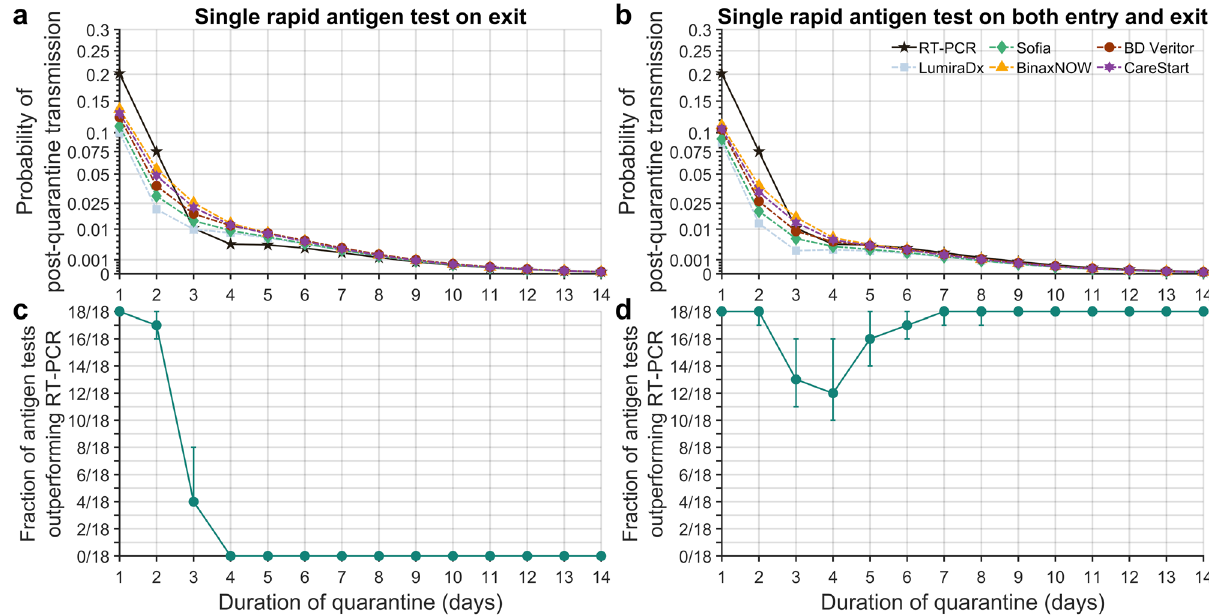
Fig. 2 Probability of post-quarantine transmission. Specifying a negative-binomial distribution for expected post-quarantine transmission, 35.1% of infections being asymptomatic, a 24-h delay in obtaining RT-PCR test results, no delay in receiving rapid antigen test results, an incubation period of 4.4 days, self-isolation upon symptom onset, and the diagnostic sensitivity curve for RT-PCR based on data from Hellewell et al 11 , the probability of post- quarantine transmission when conducting an RT-PCR test only on exit (solid line; black stars) and the rapid antigen tests (dashed lines) LumiraDx (light- blue squares); So fi a (green diamonds); BinaxNOW (yellow triangles); BD Veritor (dark-red circles); and CareStart (purple hexagram) performed a on exit and b on both entry and exit; and the fraction of the 18 rapid antigen tests whose use conferred a lower probability of post-quarantine transmission than did an RT-PCR test conducted 24 h before exit from quarantine, when the rapid antigen test was conducted c on exit and d on both entry and exit. The whiskers denote the 95% credible interval based on 1,000 samples of an RT-PCR diagnostic sensitivity curve and rapid antigen percent positive agreement curve conducted through importance